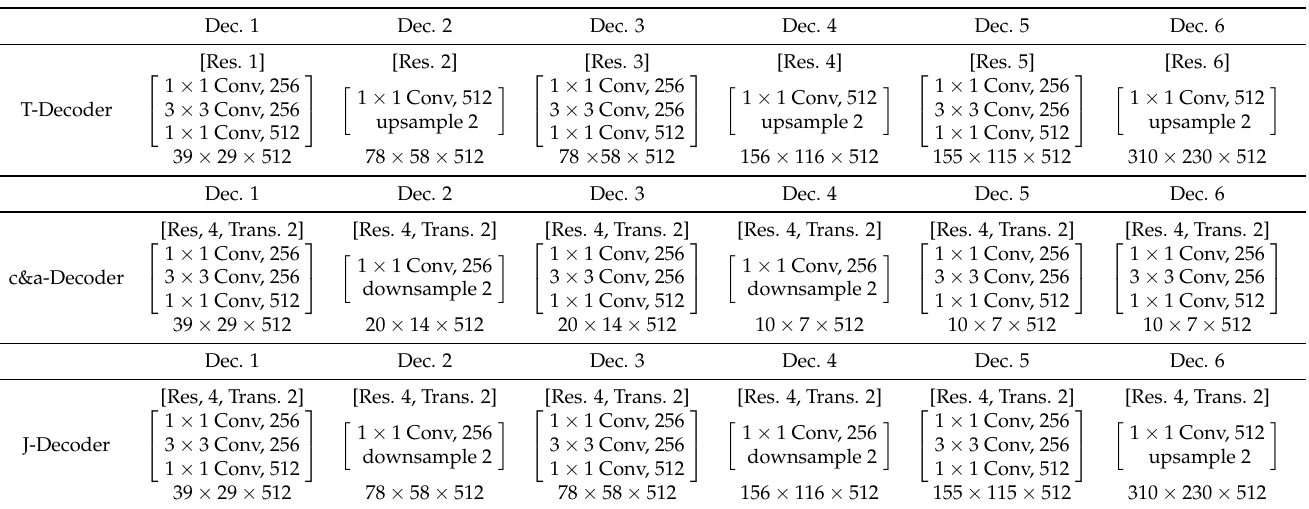
Table 2. Decoder